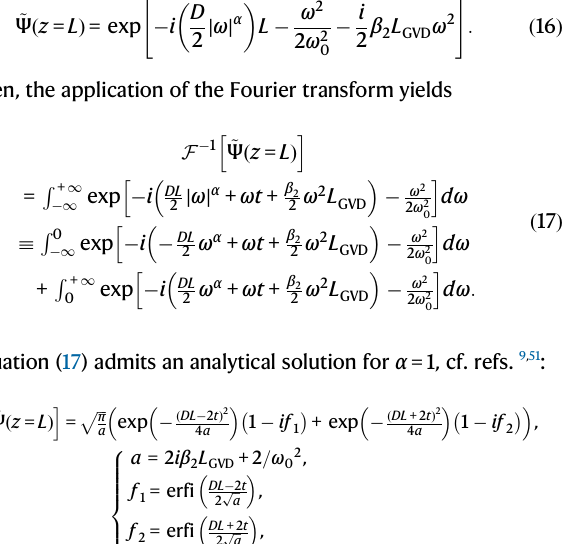
Figure6c, ddisplaythepulsedynamicsbasedon Eq.(18).Itisseen